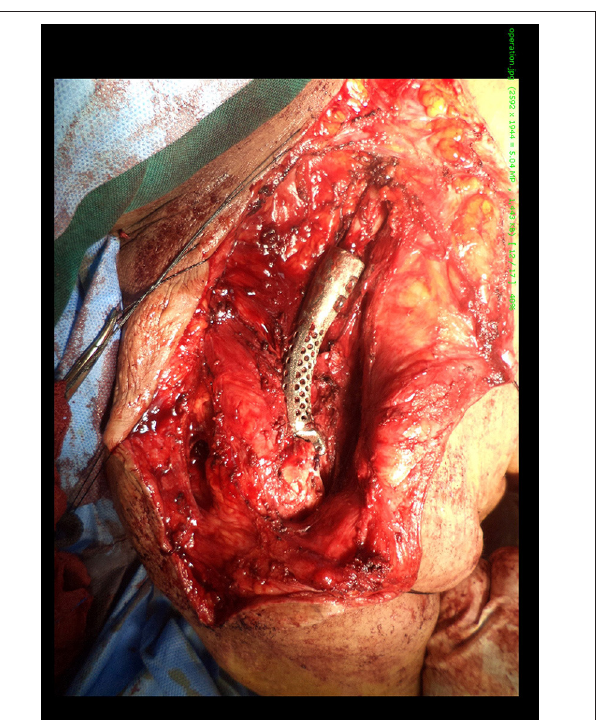
FIGURE 5 | Implantation of the prosthesis. The prosthesis was fixed with the remaining normal portion of the clavicle using a press fit, and the entire prosthesis was filled with a synthetic bone substitute.